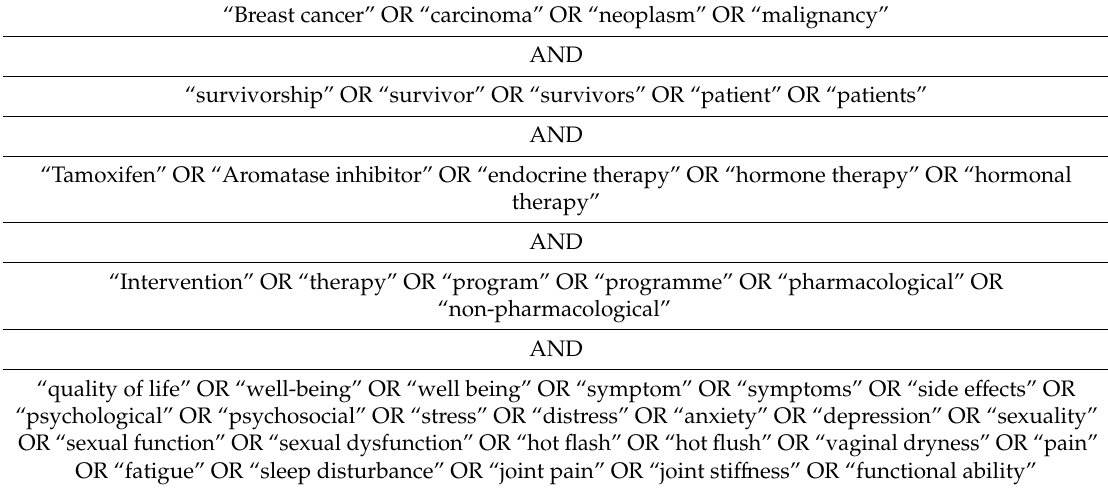
Table 1. The Search